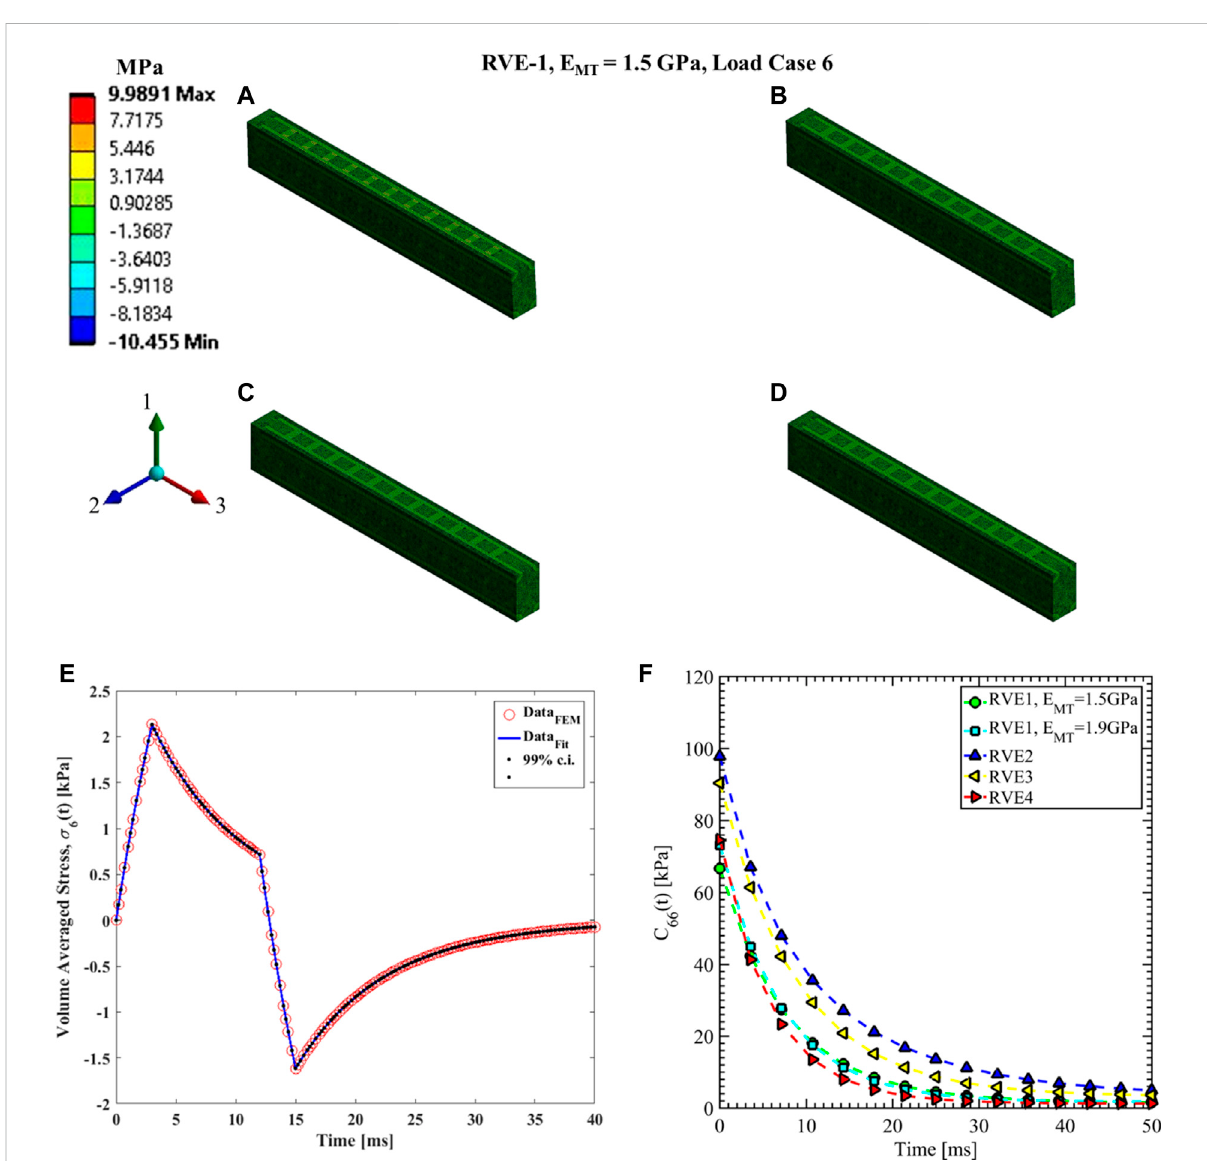
FIGURE 14 Contour plot of the element shear stress in directions 1 and 2 ( [ σ 6 ( t )] ρ from Eq. 16). C 66 ( t ) estimation for the RVE-1 with E MT (cid:2) 1 . 5 GPa by imposing the load case 6. (A) t 1 (cid:2) 3 ms , δ 6 ( t 1 ) (cid:2) 3 nm (B) t 2 (cid:2) 12 ms , δ 6 ( t 2 ) (cid:2) 3 nm (C) t 3 (cid:2) 15 ms , δ 6 ( t 3 ) (cid:2) 0 nm (D) t 4 (cid:2) 40 ms , δ 6 ( t 4 ) (cid:2) 0 nm . (E) Nonlinear regression data fi t with 99% con fi dence interval (c.i.) is shown for volume averaged shear stress in directions 1 and 2 for RVE-1, E MT (cid:2) 1 . 5 GPa for load case 6. (F) Comparison of C 66 ( t ) for different